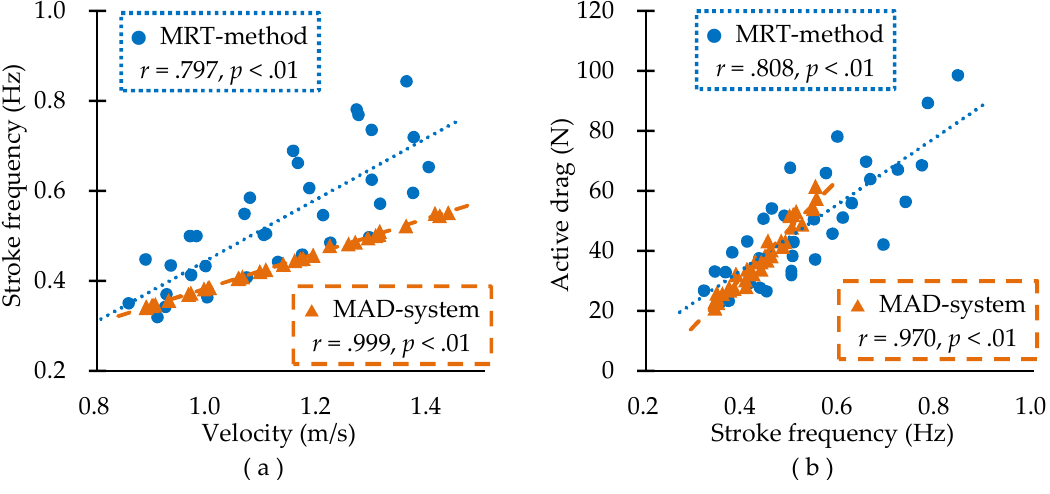
Figure. 4 The relationship between each variables in MRT-method (blue) and MAD-system (orange) for all swimmers. ( a ) The relationship between swimming velocity and stroke frequency; ( b ) the relationship between stroke frequency and active